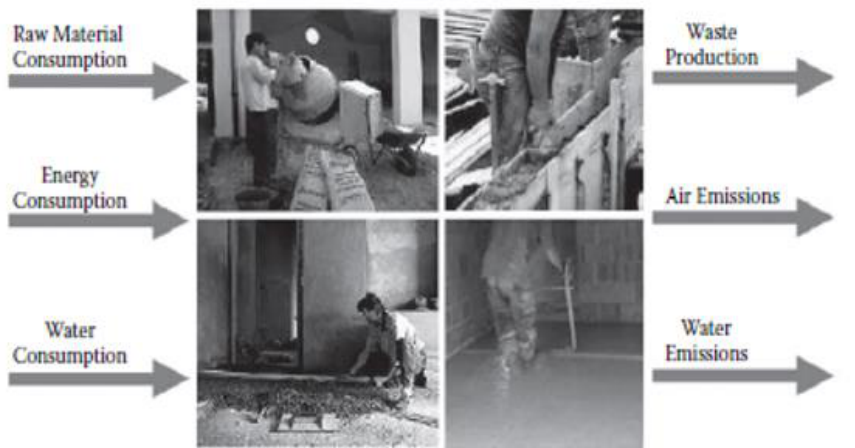
Figure 4. Waste management can include solid, liquid or gaseous materials [10]